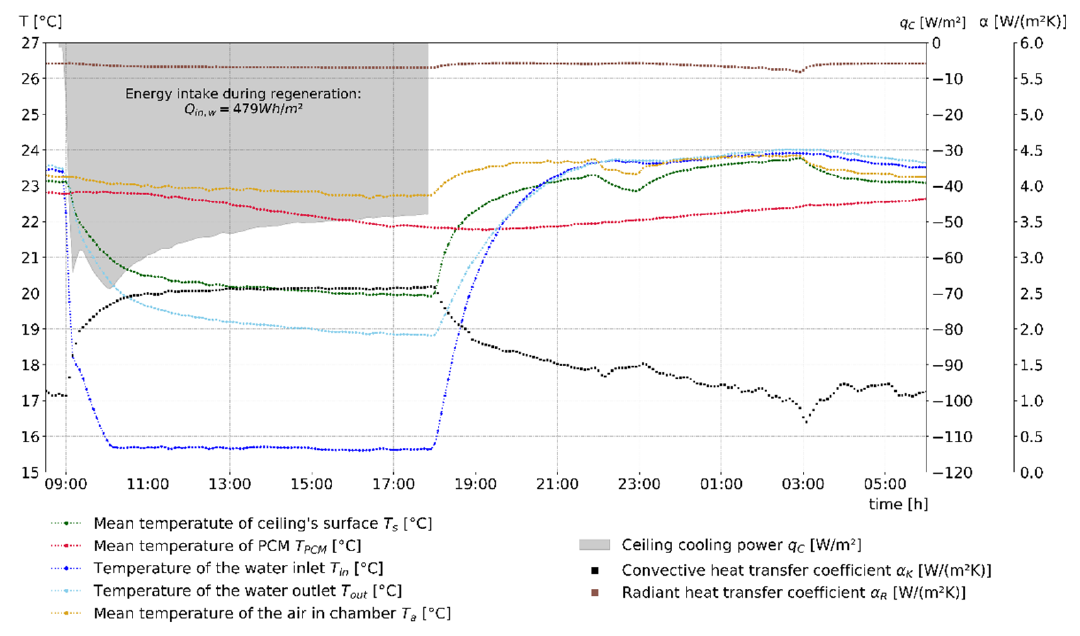
Figure 11. Experimental results for variant IIIb. Table 2. Description of analyzed variants—unsteady